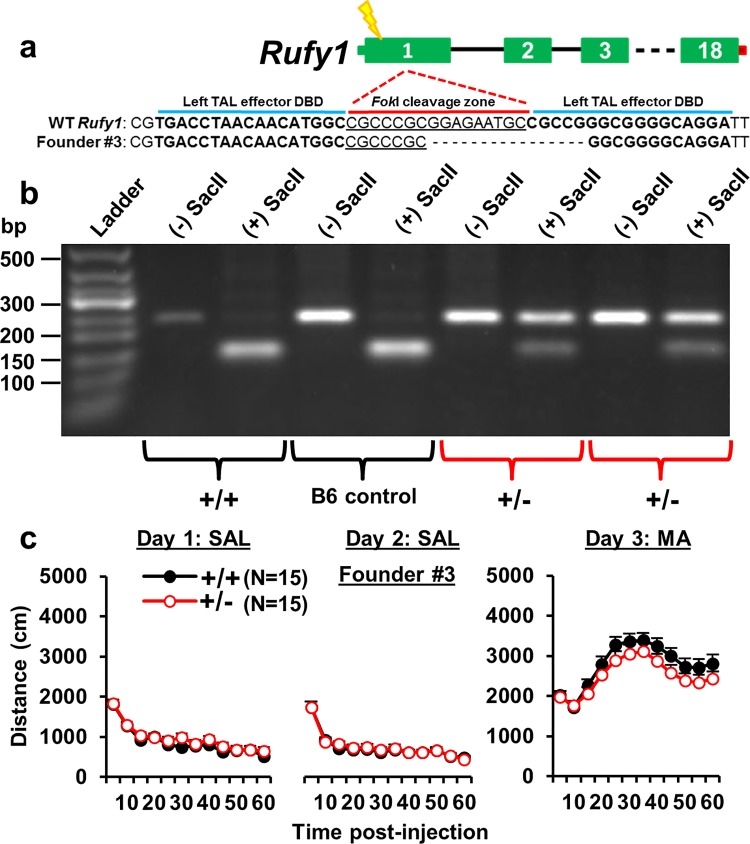
TALENS-targeted frameshift deletion in Rufy1
+/- mice.
(a): A left TALE effector (50,244,600–50,244,616 bp) and a right TALE effector (50,244,569–50,244,585 bp) separated by the FokI cleavage zone were used to introduce a frameshift deletion that resulted in a premature stop codon in the first coding exon of Rufy1 (see S8 Fig). (b): A PCR amplicon was generated that captured the FokI cleavage zone and a single SacII restriction site and was subjected to restriction digest with SacII. Rufy1
+/+ mice contained the SacII restriction site and thus, showed only a single, smaller band. Rufy1
+/- mice showed both the SacII-digested band and a larger, undigested band, indicating the presence of the deletion. (c): There was no effect of genotype or genotype x time interaction in Rufy1
+/- versus Rufy1
+/+ mice from Line #3 on Days 1, 2, or 3 (p > 0.05; S3 Table). Data are presented as the mean ± S.E.M.